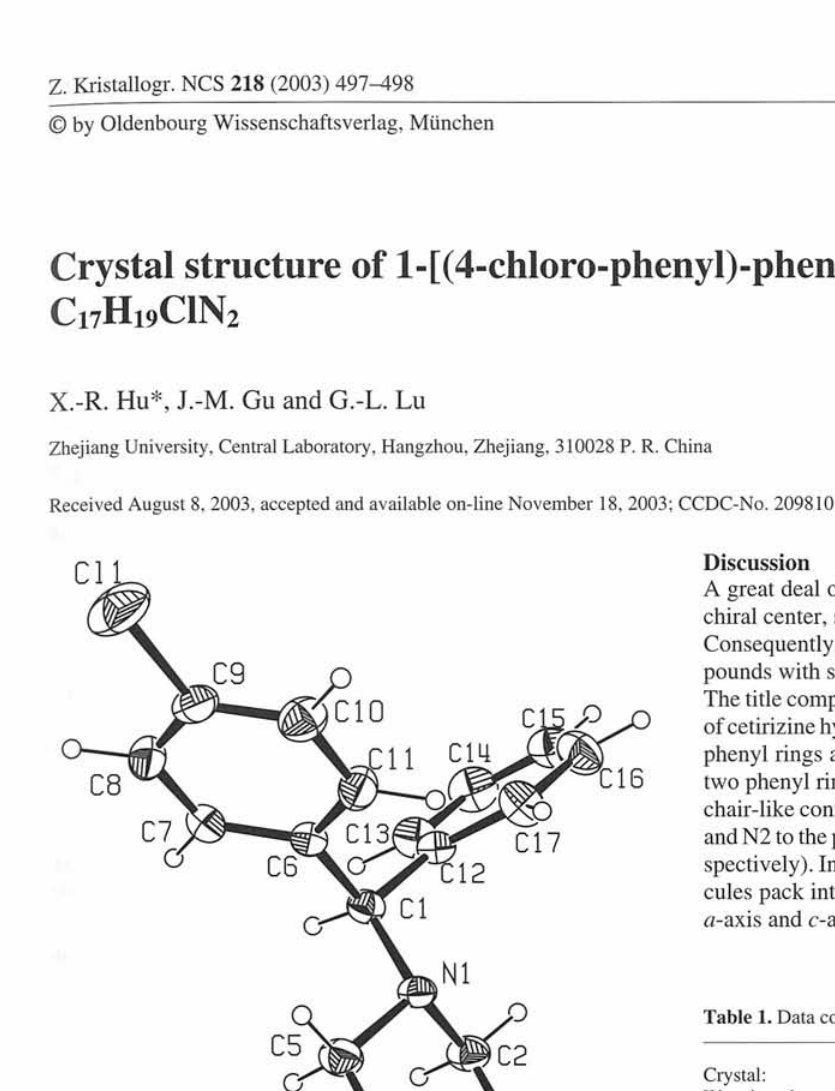
Table 1. Data collection and handling. Crystal: